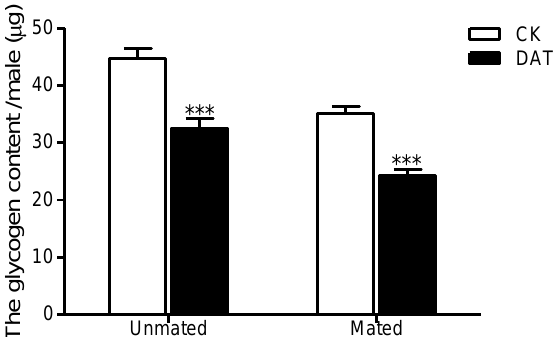
Figure 4. The glycogen content of males was determined in the CK group (at 19 h after emergence) and DAT group (males treated with 0.01% diallyl trisulfide for 7 h at 12 h after emergence) both before and after mating. The data in the figure are presented as the mean ± SEM. Asterisks depict significant differences relative to the control treatment (***, p < 0.001).